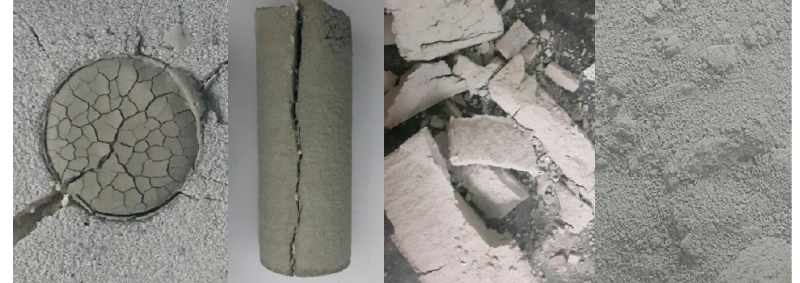
Figure 17. Disintegration of SCDA.